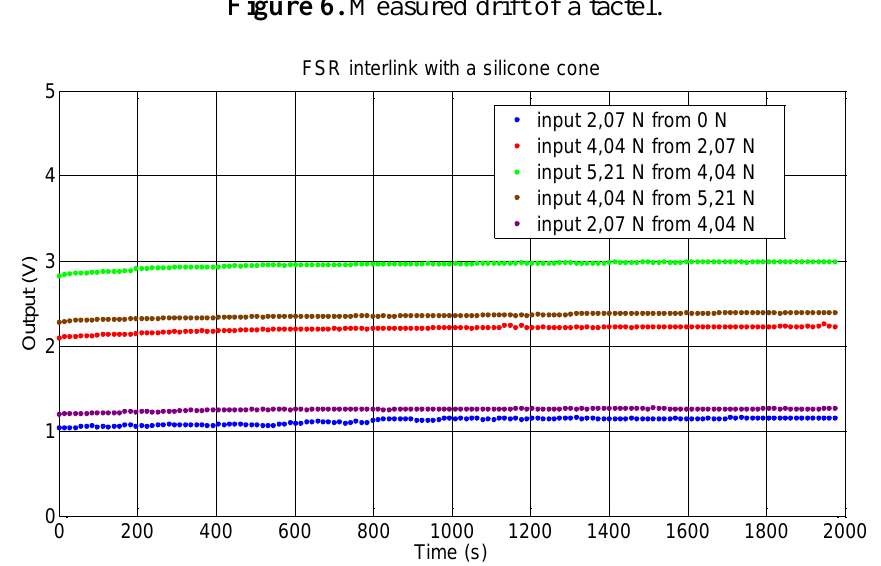
Figure 6. Measured drift of a